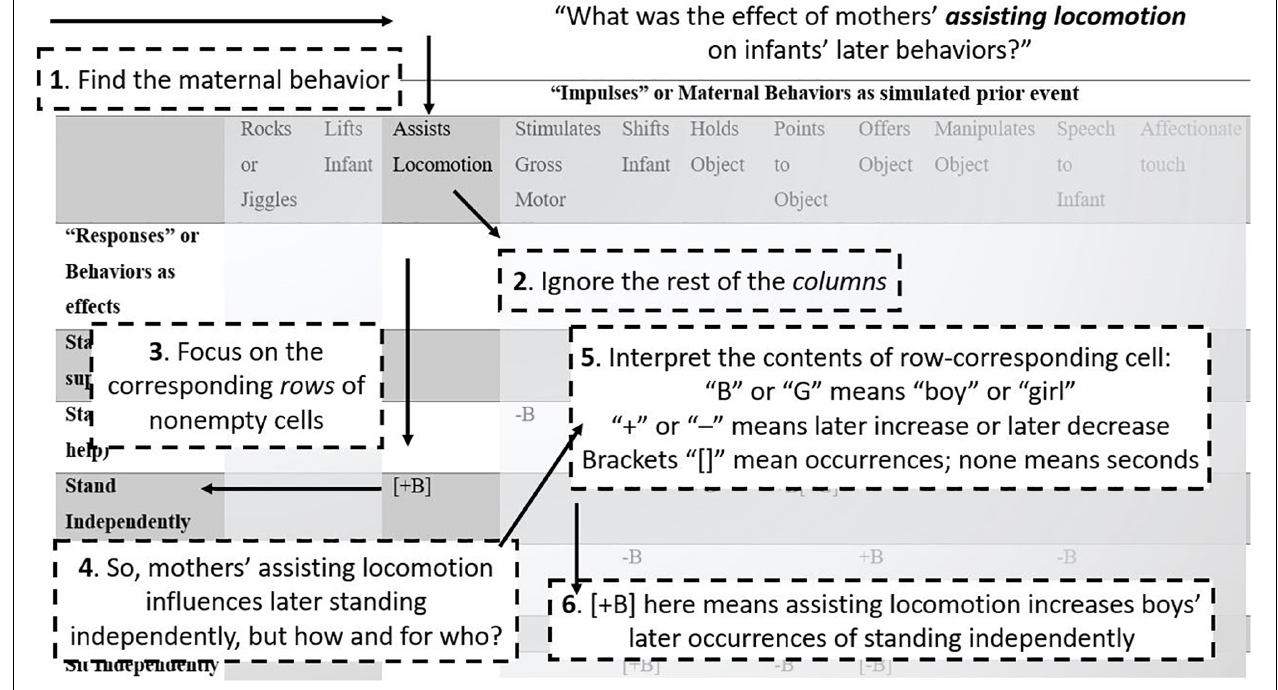
FIGURE 3 | How to read the tables. A step-by-step guide to reading Tables 2 , 3 , guiding readers through Table 3 as an example, following the question “What was the effect of mothers’ assisting locomotion on infants’ later